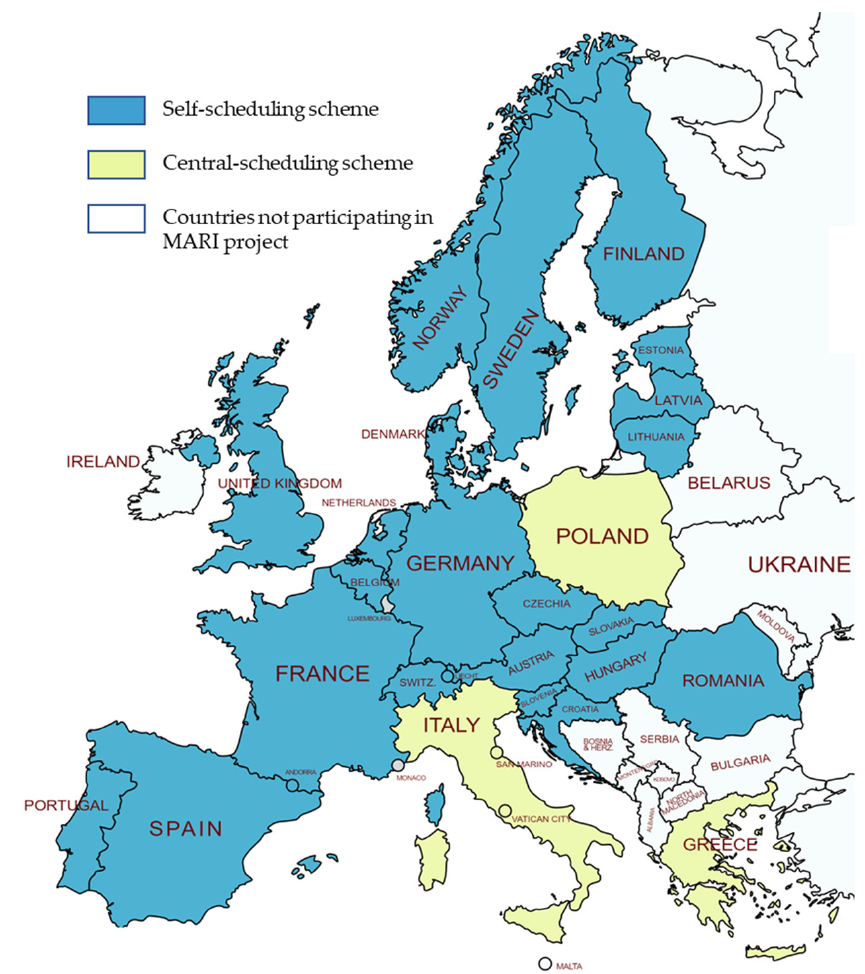
Figure 5. European control areas included in the herein described test case.